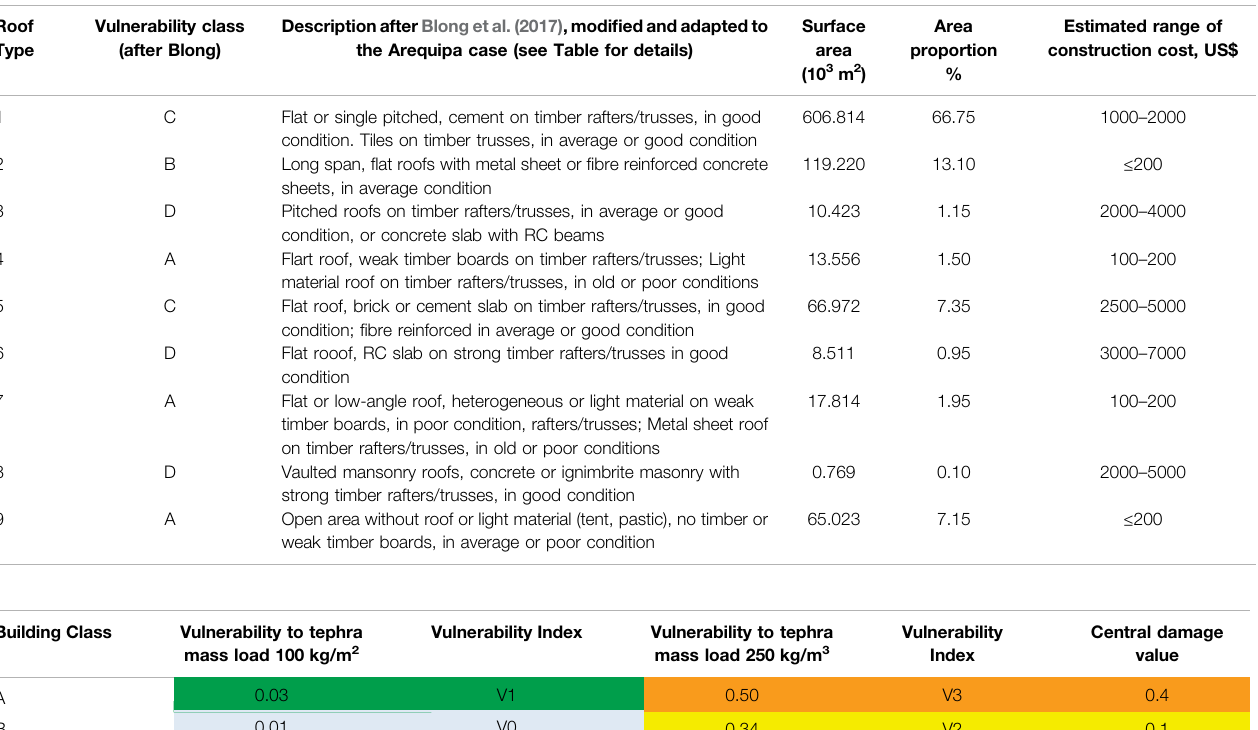
TABLE 5 | Structural description and vulnerable classes of roofs with estimated range of construction cost. Vulnerability index and damage value. Inset graphics represent tephra load vs thickness for two tephra-fall deposits taken as probable eruptive scenarios of El Misti, i.e., the mid-15th Century vulcanian event (maximum 10 cm thickness over the city area) and the c. 2070 yr BP Plinian eruption (maximum 50 cm thickness over the city area). Damage value after Blong et al (2017): 0 No damage; 1 Light damage (gutters), cleanup required; 2 Moderate damage, bending or excessive damage to as much as half roof sheeting and/or purlins, Interior requires cleaning, repainting, and/or overhaul of electrical systems; 3 Heavy damage to roof structure and some damage to walls; at least one wall damaged. Collapse of part of